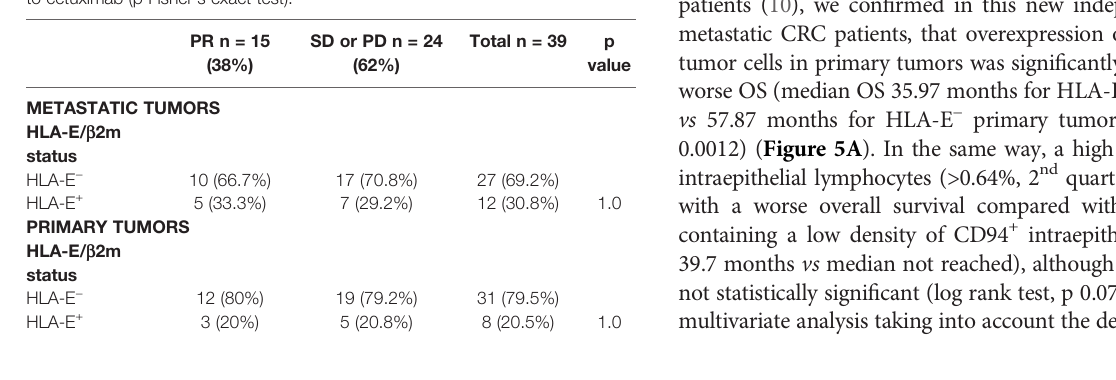
TABLE 5 | Relation between HLA-E/ b 2m overexpression and objective response to cetuximab (p Fisher ’ s exact